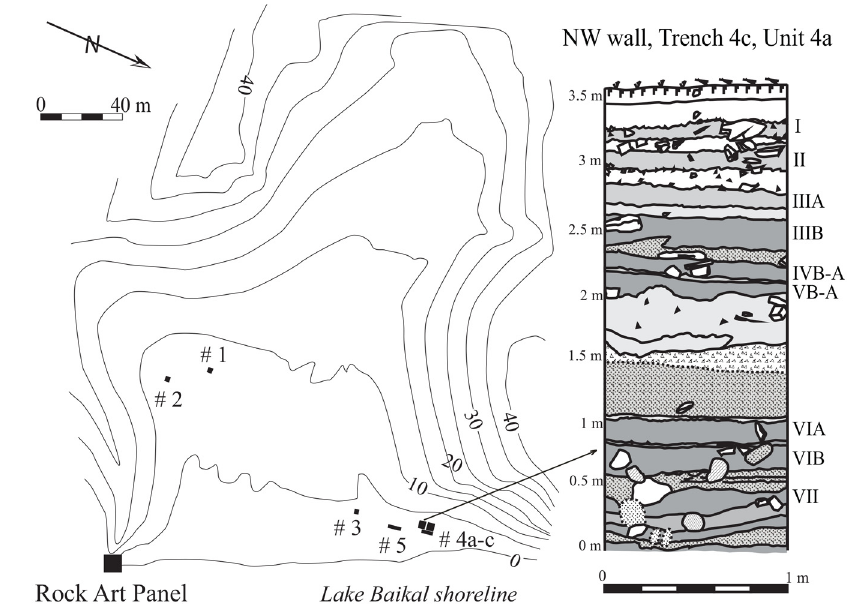
Fig 2. Map of Sagan-Zaba cove with locations of rock art panel and trenches (#1 – 3, 4a-c, and 5) indicated, and a stratigraphic column of trench 4c. Detailed description of site stratigraphy is provided in Nomokonova (2011) and Nomokonova et al.